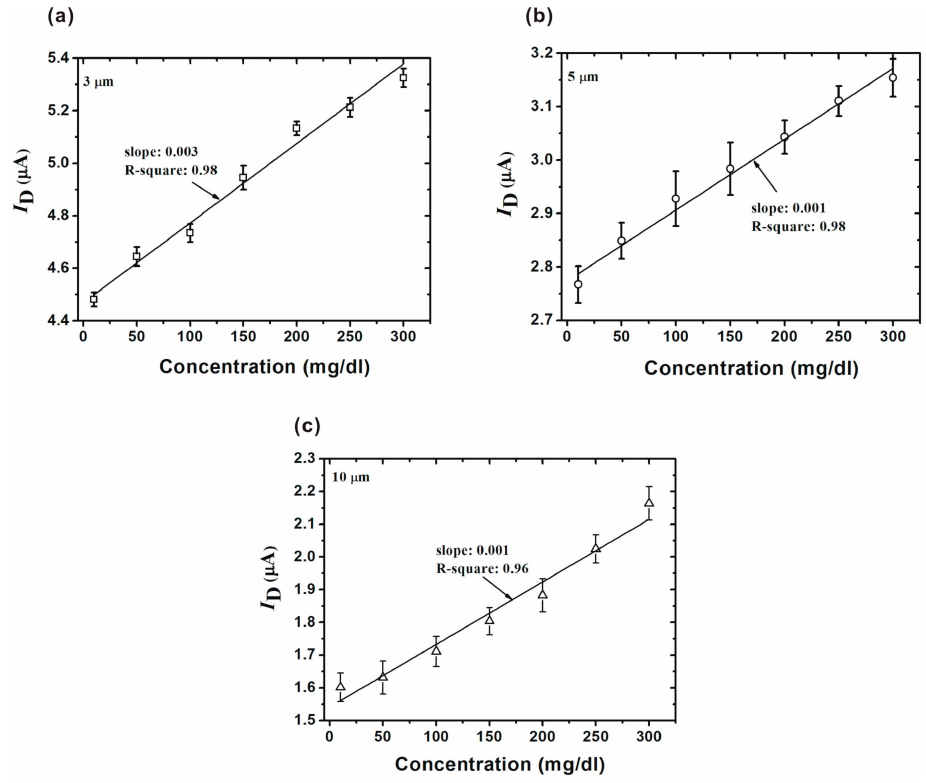
Figure 5. Calibration curves of the proposed sensor with nanowire lengths of ( a ) 3 µm, ( b ) 5 µm and ( c ) 10 µm.